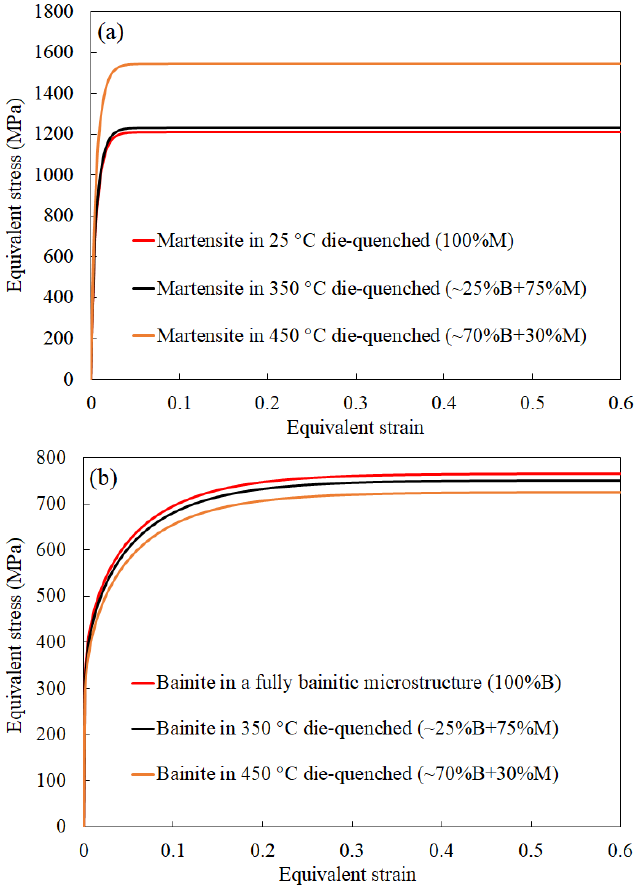
Figure 14. The calculated flow curves for ( a ) martensite and ( b ) bainite in various die-quenched microstructures of Ductibor ® 1000-AS using Rodriguez and Gutierrez’s model (Equation (8) [43]). The computed equivalent stress-strain data for bainite in a fully bainitic microstructure is also displayed for comparison. Table 6. The carbon concentrations of the bainitic and martensitic phases in various material condi- tions/microstructures of Ductibor ® 1000-AS.